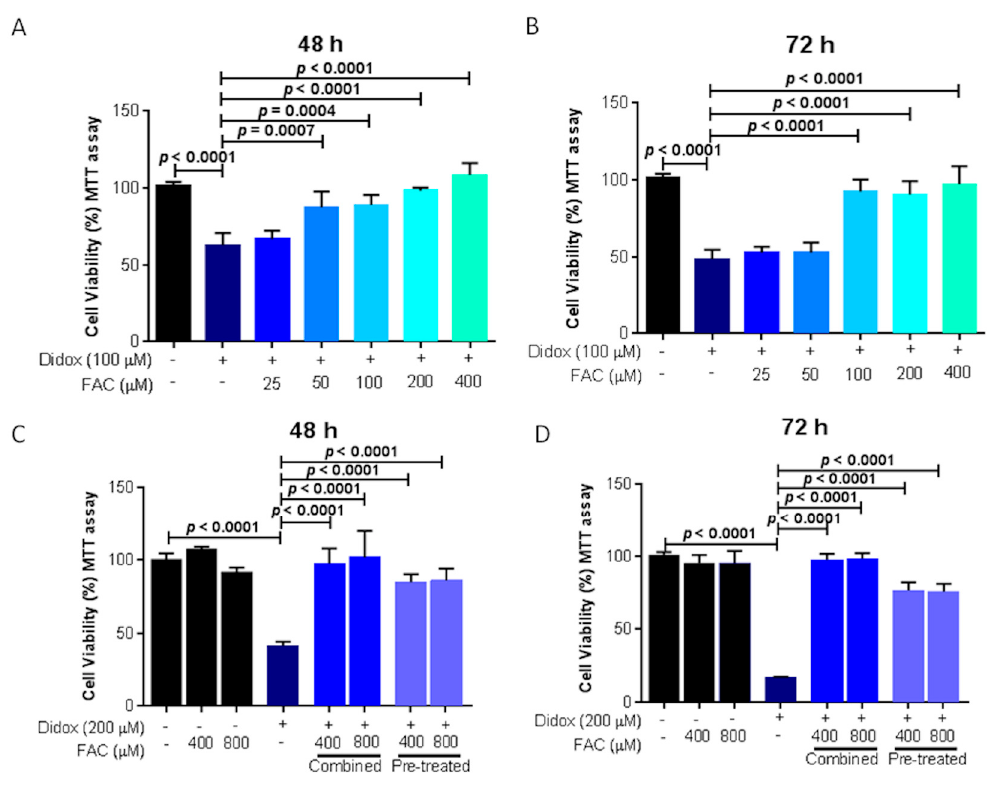
Figure 7. Treatment with equimolar concentration of iron rescued didox-induced cell death. HA22T / VGH cells were untreated or treated with: 100 µ M didox alone or in combination with increasing concentration of FAC (25, 50, 100, 200 and 400 µ M) for 48 ( A ) and 72 h ( B ). ( C , D ) HA22T / VGH cells were untreated or treated with 400–800 µ M FAC, 200 µ M didox for 48 and 72 h, in combination FAC plus didox (combined) or HA22T / VGH cells were pre-treated with 200 µ M didox (for 16 h) and then 400–800 µ M FAC was added to the cells (pre-treated) for 48–72 h. Cell viability was verified by an MTT assay and the values expressed as % of viable cells over the untreated cells at the indicated time point. The graphs are means of three independent experiments ( N = 3) with three internal values for each experiment.